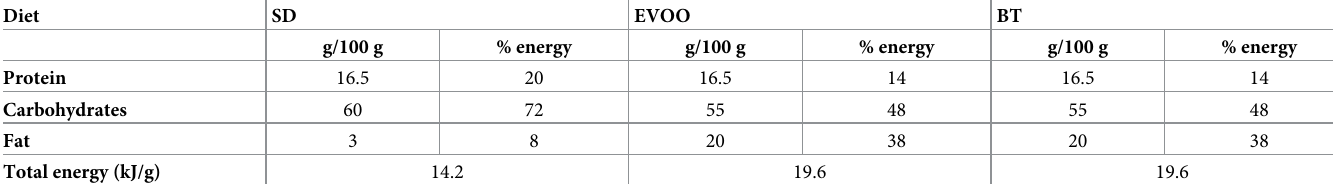
Table 6. Nutrient composition and energy content of standard and high fat diets enriched with extra virgin olive oil and butter.